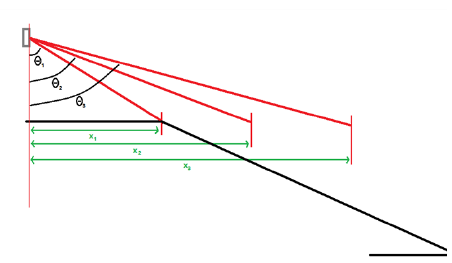
Figure 7. Descending Ramp Modelling Diagram.